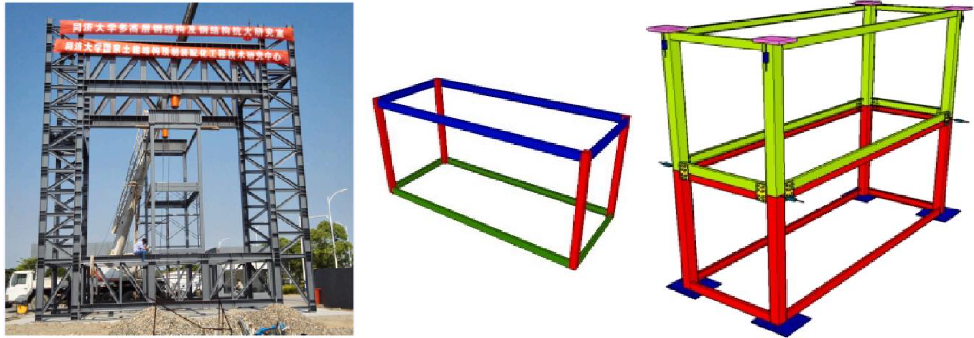
Figure 4. Adopted modular building and module [19] . Reprinted with permission from Ref. [19] ©2020, Elsevier Ltd.